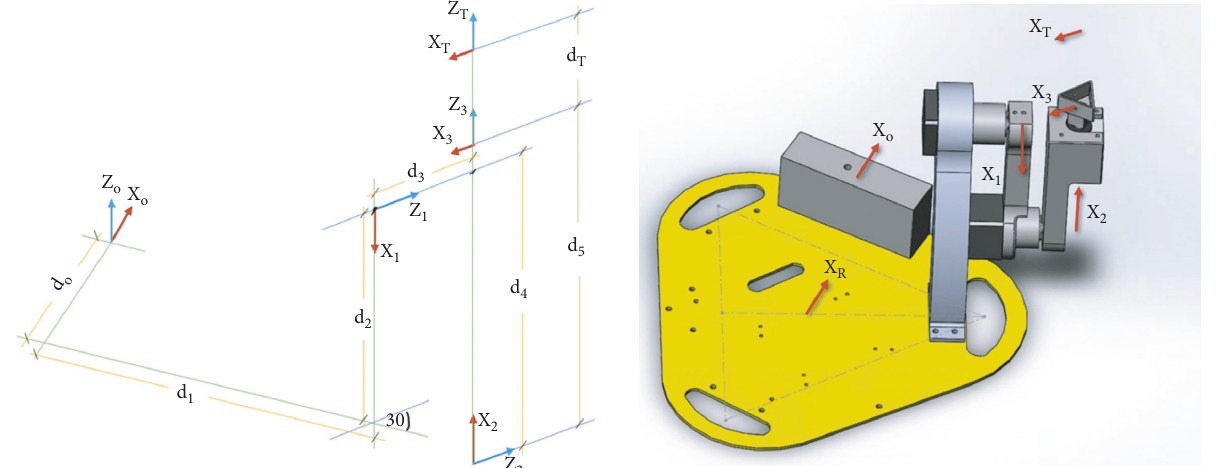
Figure 6: Location of Frames.